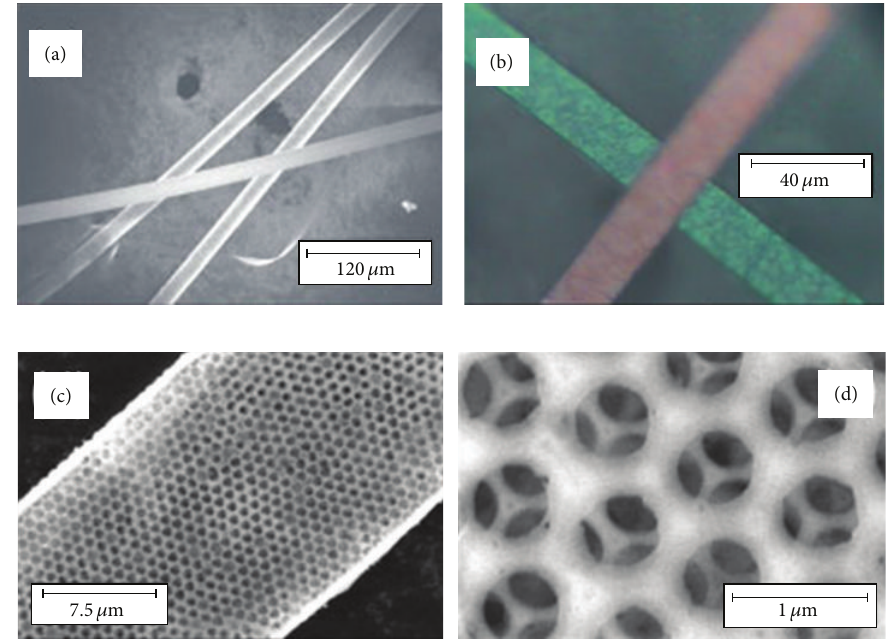
Figure 19: Images of inverse silicon microfibers. (a) SEM image of a bunch of fibers collected using a sticky carbon tape; (b) optical picture of two fibers presenting a different degree of infiltration, thus presenting different colors; ((c), (d)) details of the bottom surface of a free standing inverted colloidal crystal fiber showing the high degree of connectivity between the spherical cavities